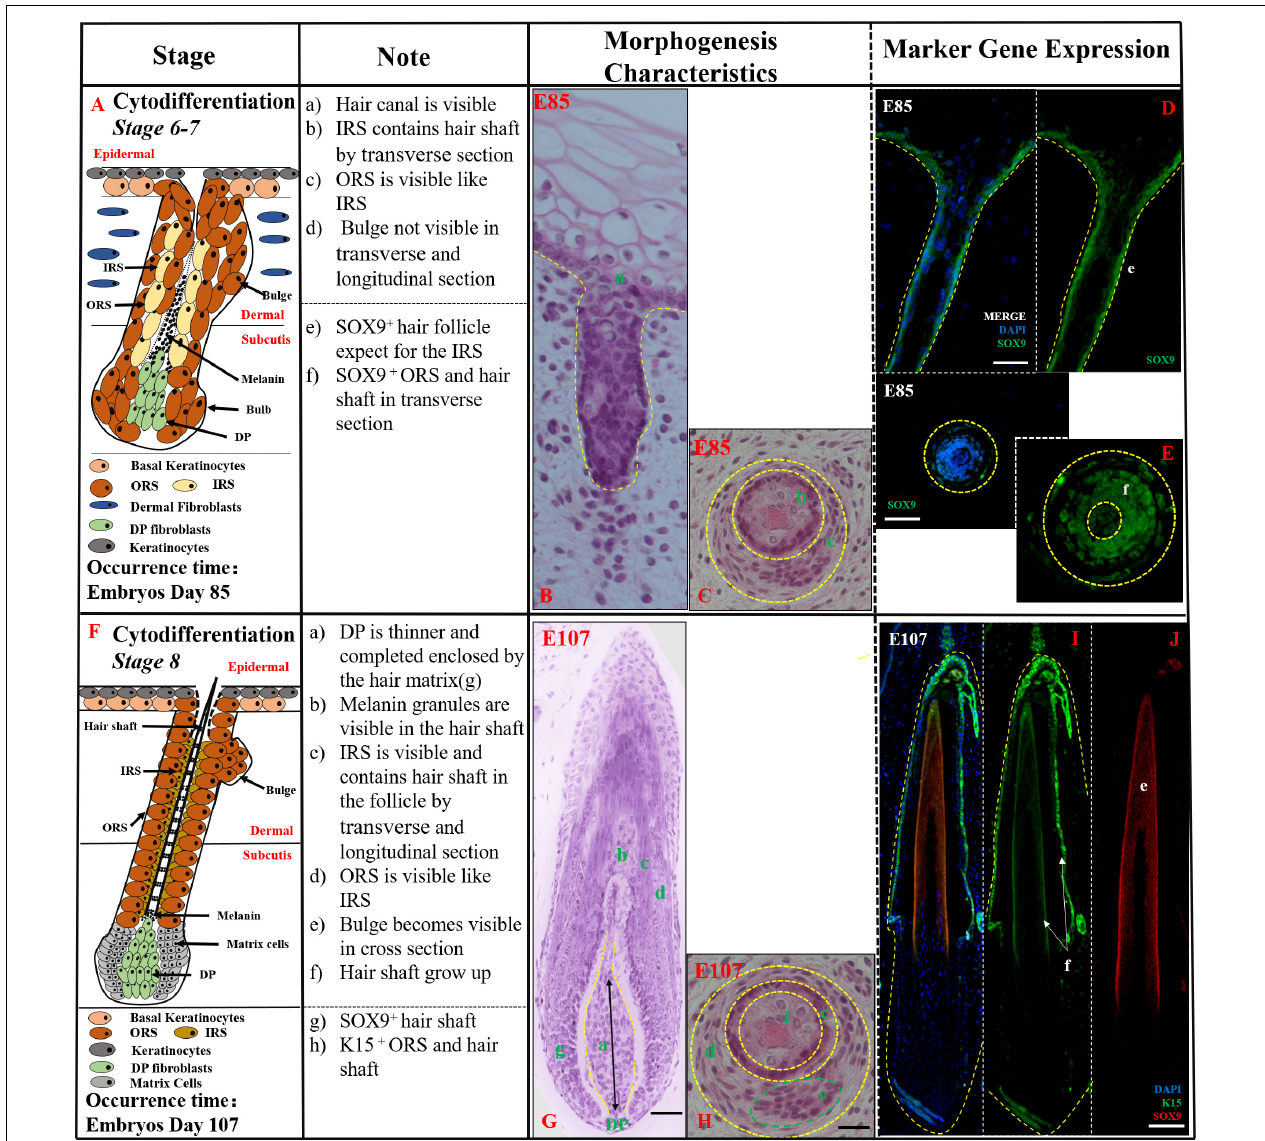
FIGURE 3 | The identification of stages 6–8 (Cytodifferentiation) of pig hair follicle morphogenesis. (A,F) A schematic diagram of stages 6–7 and stage 8 in HF morphogenesis after E85. The Note column summarizes simple basic parameters for HF stage by H&E staining (above dotted line) and marker gene expression (below dotted line). (B) The characteristics of pig hair follicle morphology at E85 by H&E. (C) Partial enlarged detail of hair follicle in part (B) ; SOX9 expression in ORS and hair shaft at E85 in longitudinal (D) and transverse (E) section by IF. (G) The characteristics of pig hair follicle morphology at E107 by H&E. (H) Partial enlarged detail of hair follicle in part (G) . (I) K15 expression in pig ORS and hair shaft at E107 by IF. (J) Sox9 expression in pig hair shaft at E107 by IF. Scale bars: 50